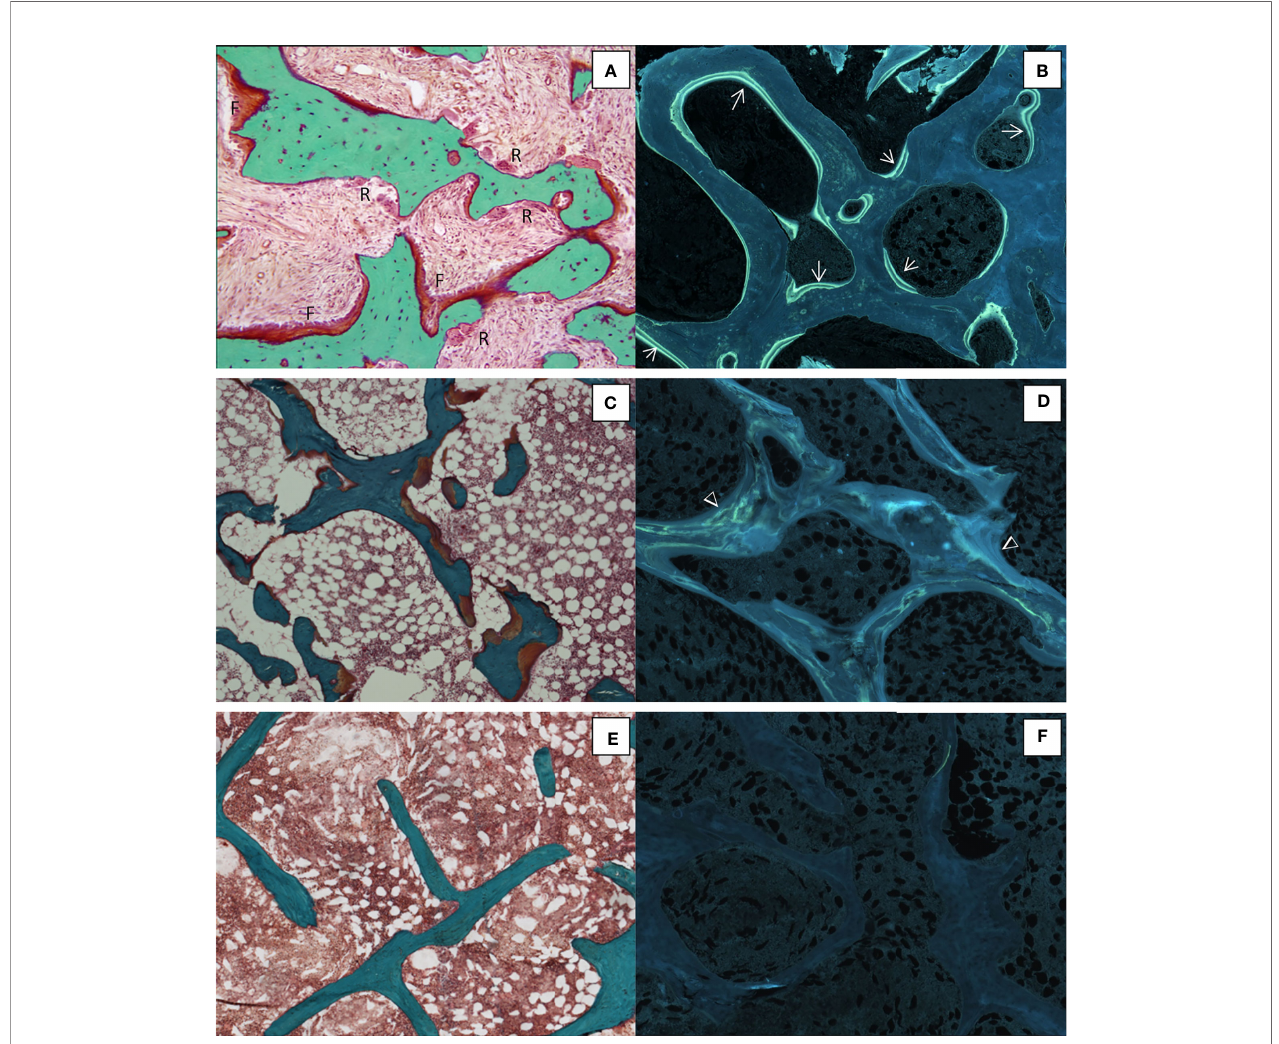
FIGURE 5 | Different histological forms of renal osteodystrophy. (A) High bone remodeling with increased bone resorption (R) and formation (F) associated with numerous tetracycline labels ( ! ) (B) ; Osteomalacia with thick osteoid seams (C) and diffuse tetracycline labels ( D ) (D) ;Adynamic bone with no active bone surface (E) with no tetracycline label (F) . (A , C , E) , Goldner trichrome; (B , D , F) , unstained sections under ultraviolet light;